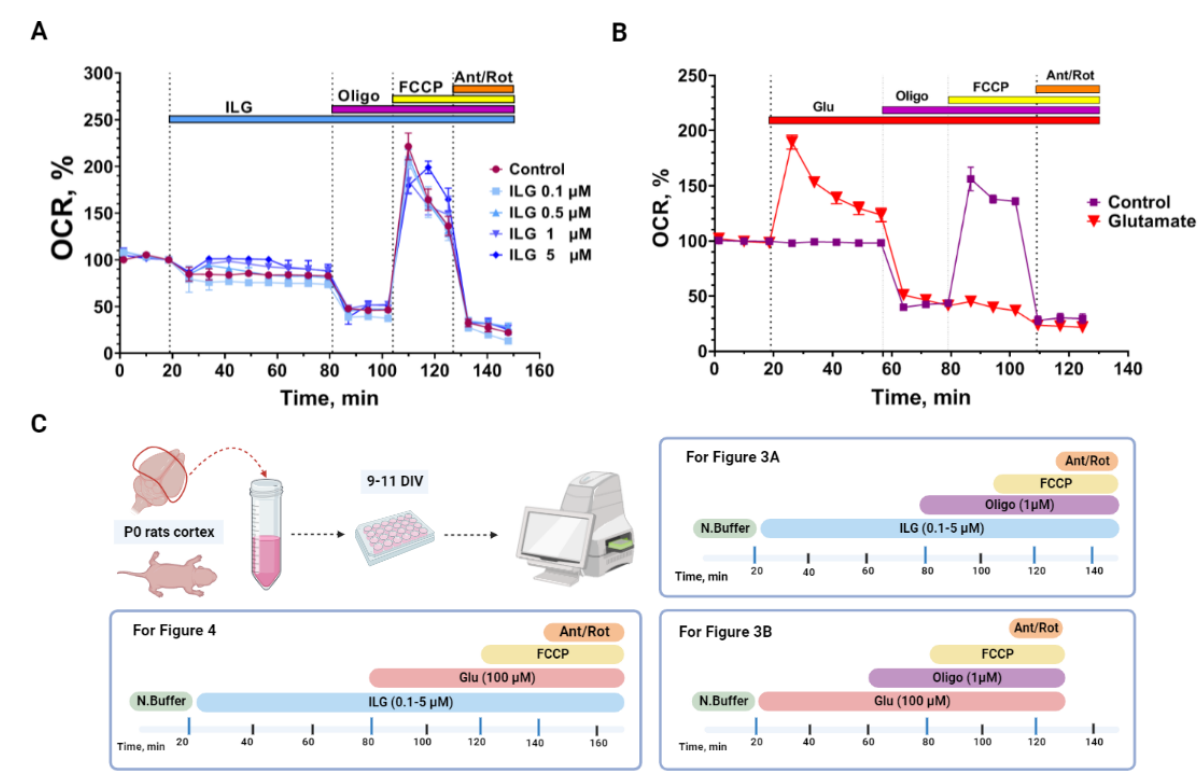
Figure 3. The results of standard mito-stress test performed with ILG/glutamate and oligomicyn. ( A ) Cumulative curve of ILG effects on OCR. ( B ) Cumulative curve of Glu effects on OCR. Figure 1. ( C ) Scheme of experiments with sequence of injection and timeline for Figures 3 and 4. 3 experiments were performed for each mito-stress test design. All data were normalized to the basal OCR of the cumulative curve (Mean ± SEM).